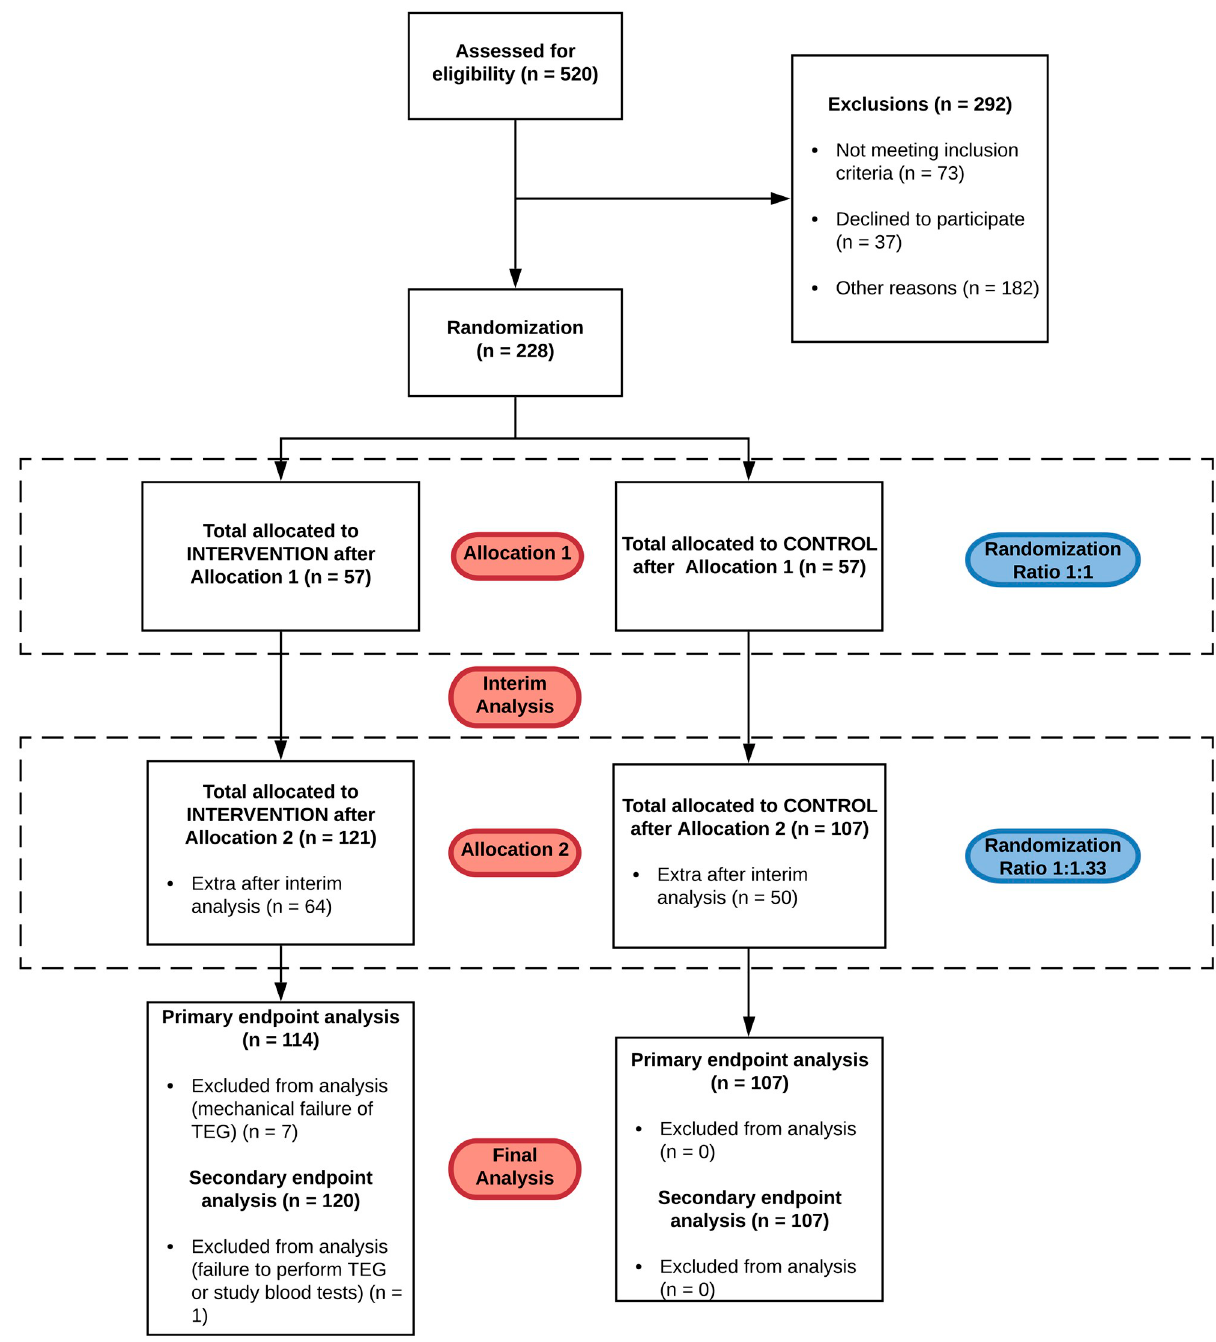
Fig 1. ACE flow diagram of trial progress. ACE, Adaptive designs CONSORT Extension; CONSORT, Consolidated Standards of Reporting Trials; TEG, thromboelastography. https://doi.org/10.1371/journal.pmed.1003658.g001 Primary endpoint. The results from 221 participants were analysed for the primary end- point (intervention group, n = 114; control group, n = 107). The mean TEG r-time measured 3 minutes post-protamine was significantly shorter in the intervention group, relative to the control group (6.58 [SD 2.5] versus 8.08 [SD 4.0] minutes; p = 0.0016; standard p = 0.0011).